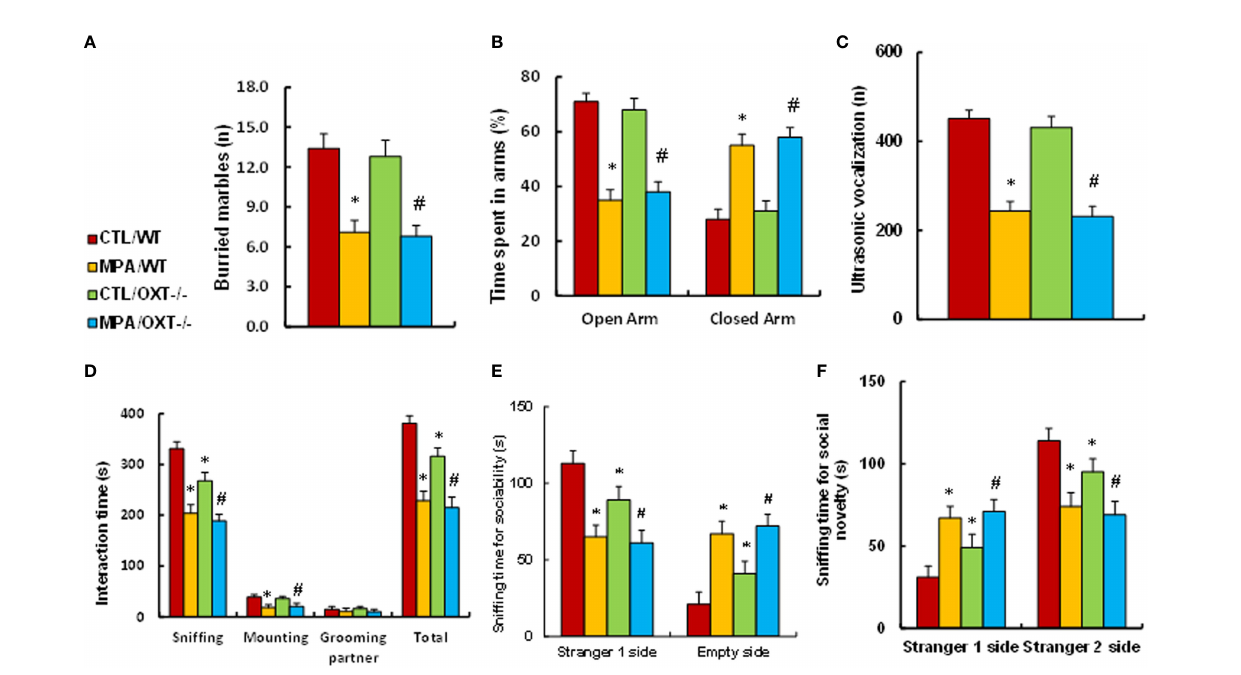
FIGURE 4 | Prenatal OXT de fi ciency partly mimics prenatal MPA exposure-mediated social de fi cits in mouse offspring. The OXT wild type (WT) or OXT null (OXT -/- ) background dams were treated by either control (CTL) or MPA, and the subsequent offspring were used for animal behavior tests. (A) MBT test, n=9. (B) EPM test, n=9. (C) Ultrasonic vocalization, n=9. (D) Social interaction (SI) test, n=9. (E, F) Three-chambered social tests for sociability (E) and social novelty (F) , n=9. * P < 0.05, vs. CTL/WT group; # P < 0.05, vs. CTL/OXT-/- group. Data were expressed as mean ±